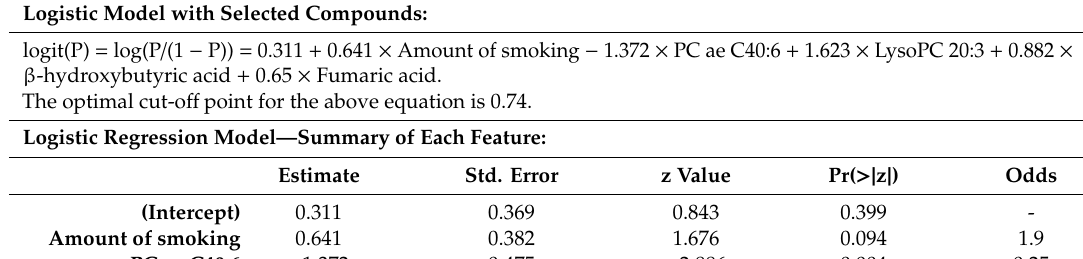
Table 3. Logistic regression based optimal model for stage I NSCLC detection: metabolites plus smoking